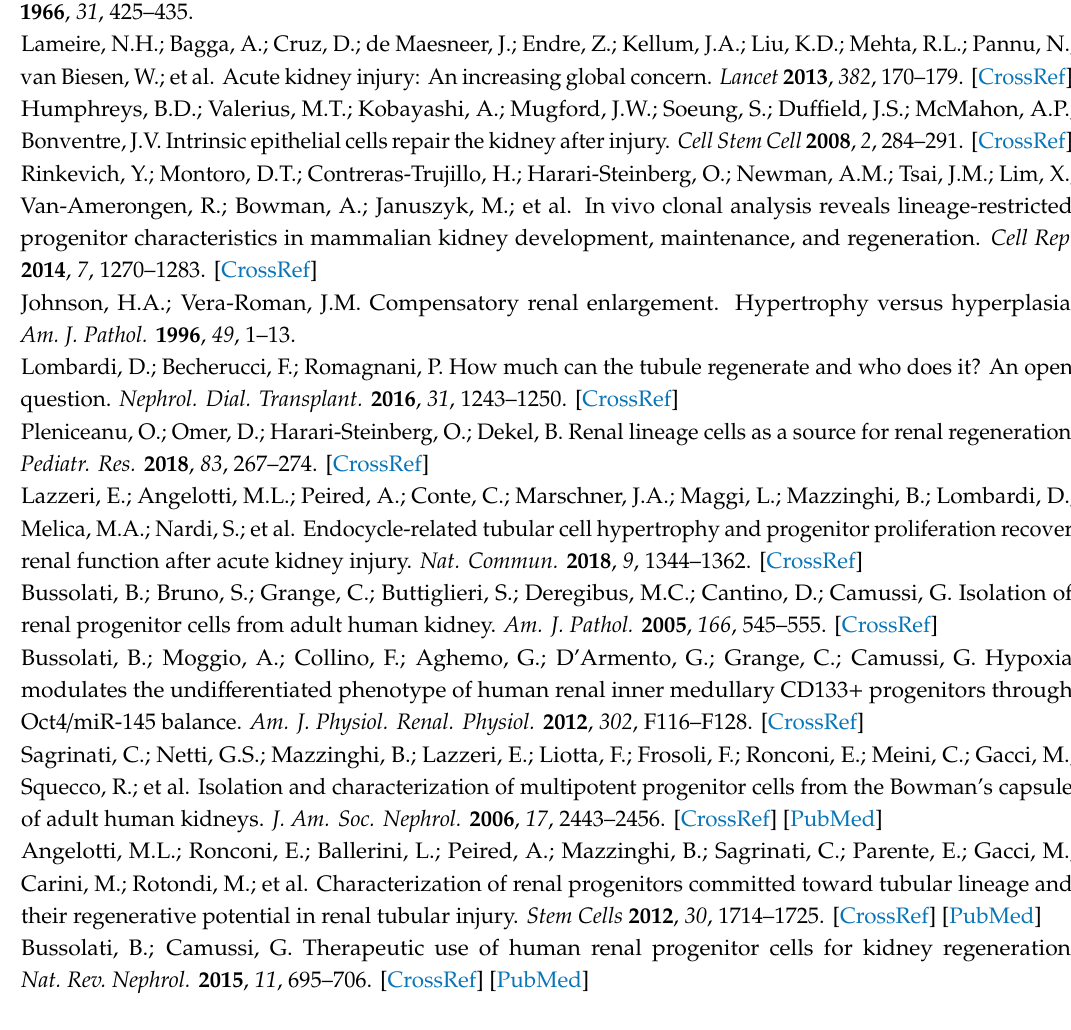
Figure S1: Histological characterization of decellularized sca ff olds repopulated with RSC; Figure S2: Di ff erentiation abilities of PKH low / neg progenitor cells; Figure S3: Histological characterization of decellularized sca ff olds repopulated with